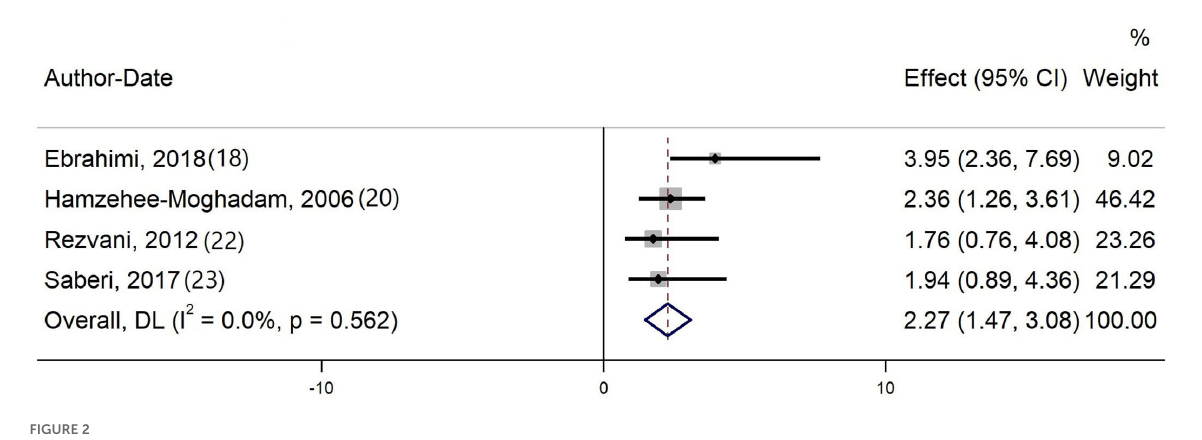
FIGURE2 Forest plot of the